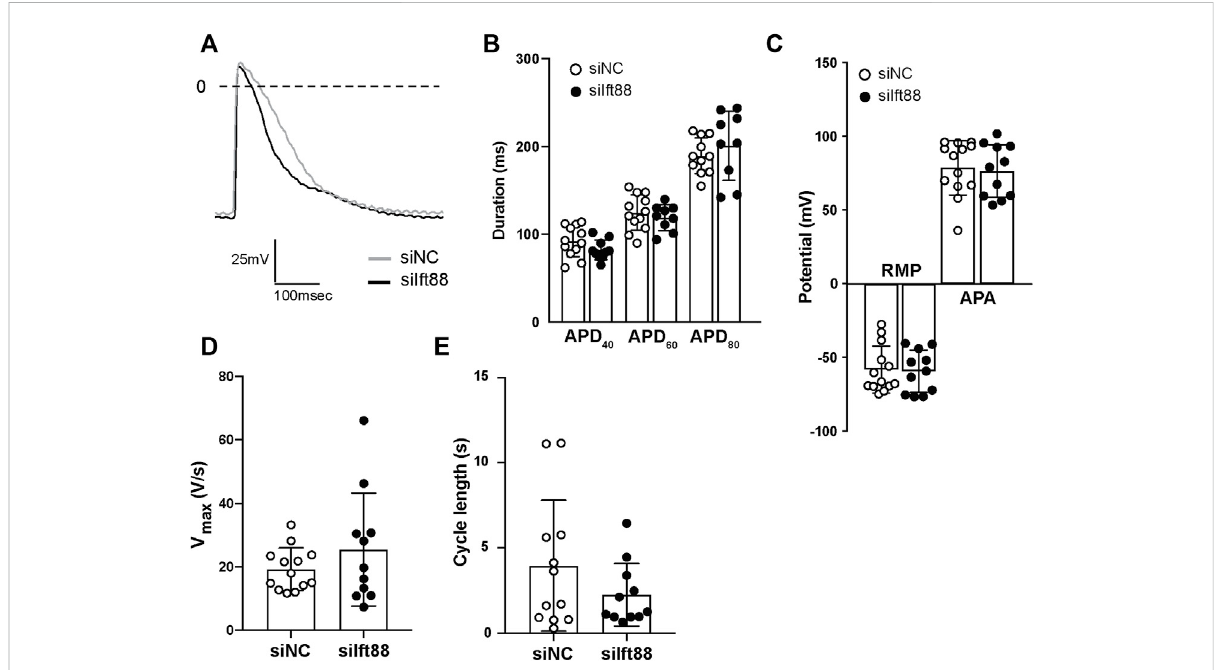
FIGURE 4 Co-culture between FB with reduced (mRNA) Ift88 expression and CM does not lead to changes of the action potential characteristics. (A) RepresentativespontaneousAPsrecordedinCMmonolayersco-culturedfor48 hwithFBpreviouslytransfectedwithsiNCorsiIft88. (B – E) Effectof co-culture on spontaneous APs duration at 40%, 60%, and 80% (APD 40 , APD 60 , and APD 80 ) of repolarization (B) , resting membrane potential (RMP), AP amplitude (APA) (C) , maximal upstroke velocity (V max ) (D) and cycle length (E) . n ≥ 9 microelectrode measurements from two independent CM/FB isolation. Data are mean ±